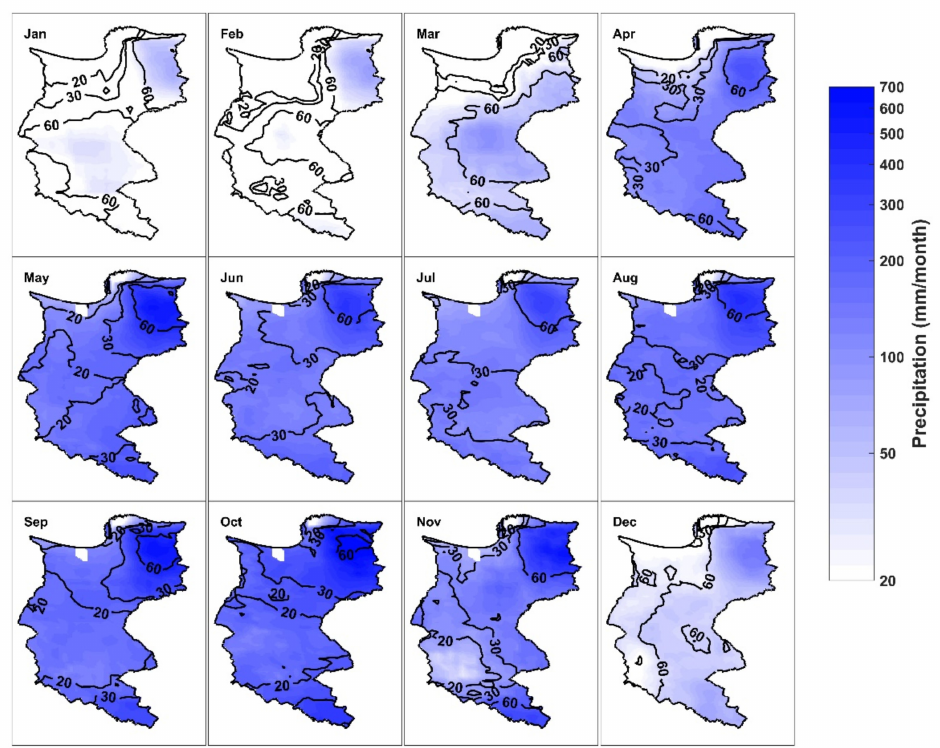
Figure 5. Spatial distribution of the monthly precipitation in the Magdalena Department for the 1981–2018 period based on the CHIRPS v2.0 database. The contours represent the coefficient of variation for each month.